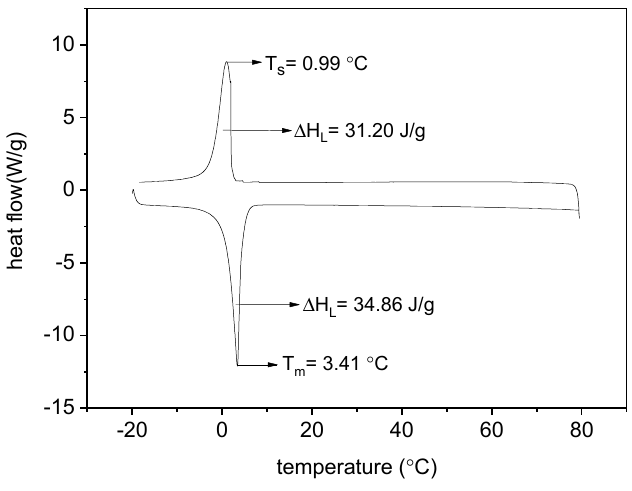
Figure 6. Thermal analysis test of the ME-LWA.